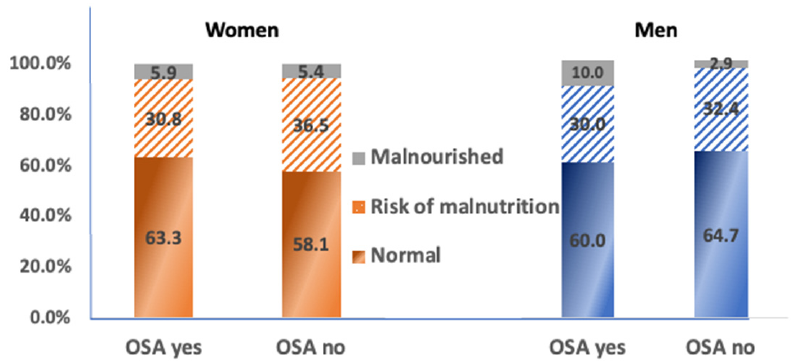
Figure 2. Distribution (%) of women and men with OSA according to nutritional status .